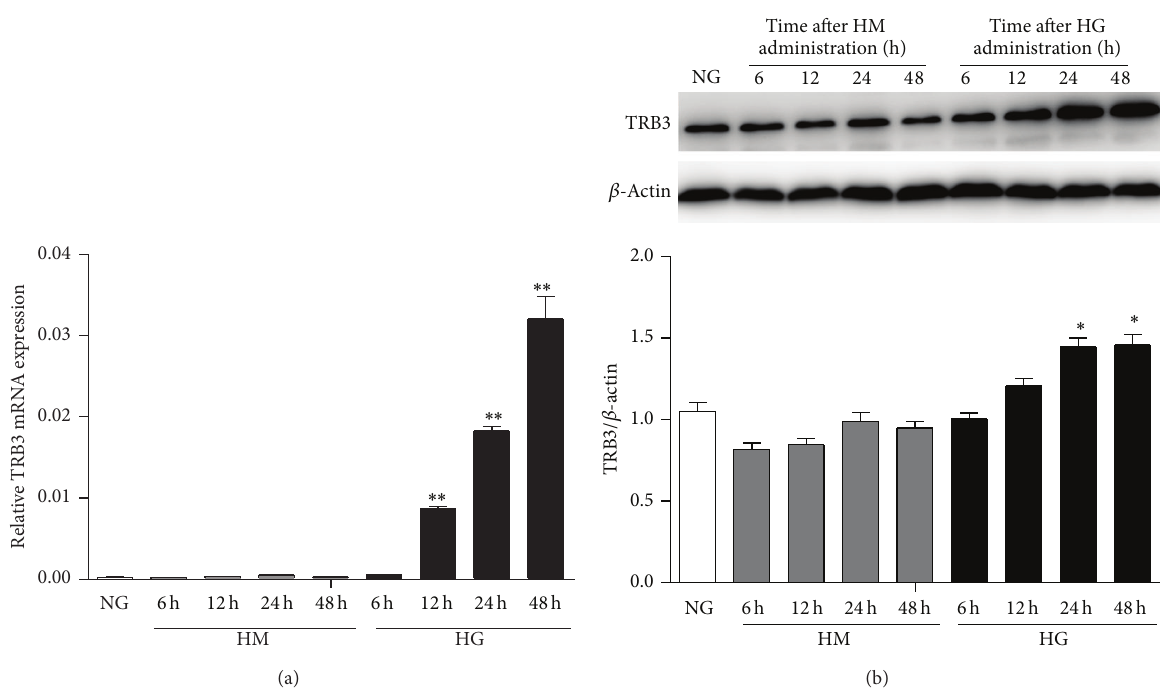
Figure 3: Effect of high glucose (HG) on TRB3 mRNA and protein levels in murine mesangial cells (MMCs) over time. MMCs were cultured in media containing NG and then stimulated with NG + high mannitol (HM) or HG for 6, 12, 24, and 48h. (a) RT-PCR analysis of the mRNA level of TRB3. (b) Western blot analysis of the protein level of TRB3. Data are mean ± SEM. ∗ 𝑃 < 0.05 , ∗∗ 𝑃 < 0.01 versus